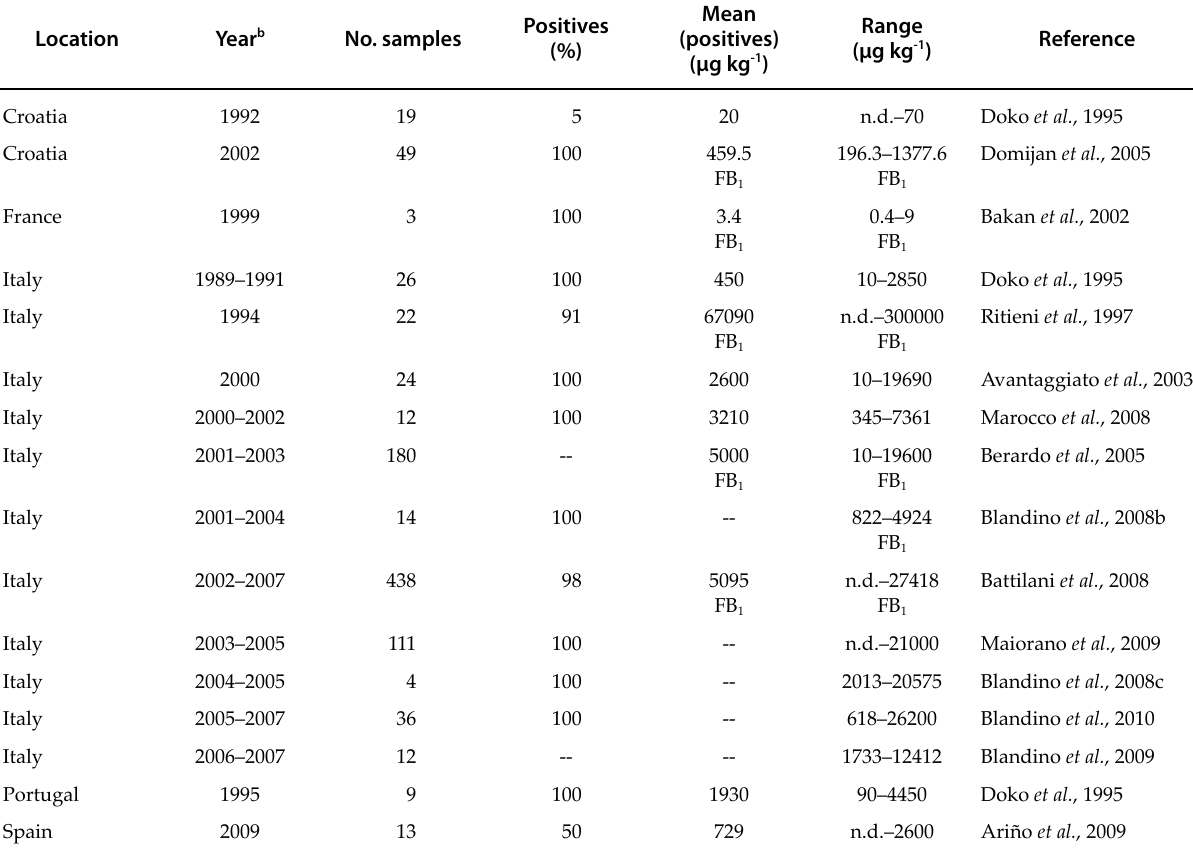
Table 2. Occurrence of fumonisins a in freshly harvested maize from Mediterranean countries.